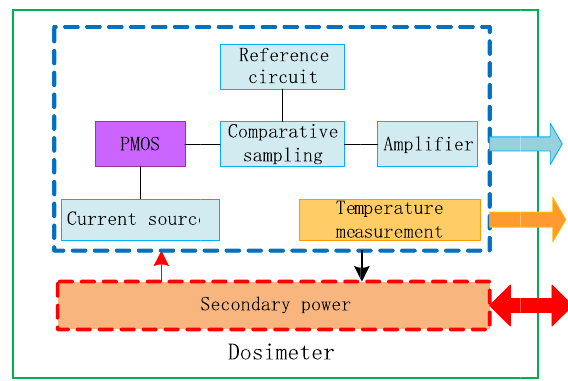
Figure 6: Working principle block diagram of single radiation